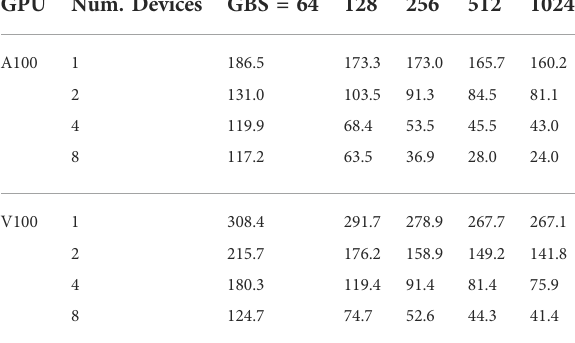
TABLE 4 Strong scaling, training time in seconds for one epoch with different GBSs using GPUs. The A100s were made available as a single DGX node with NVlink while the V100s were available across the PCI bus of a single node multi-GPU server. GPU Num. Devices GBS = 64